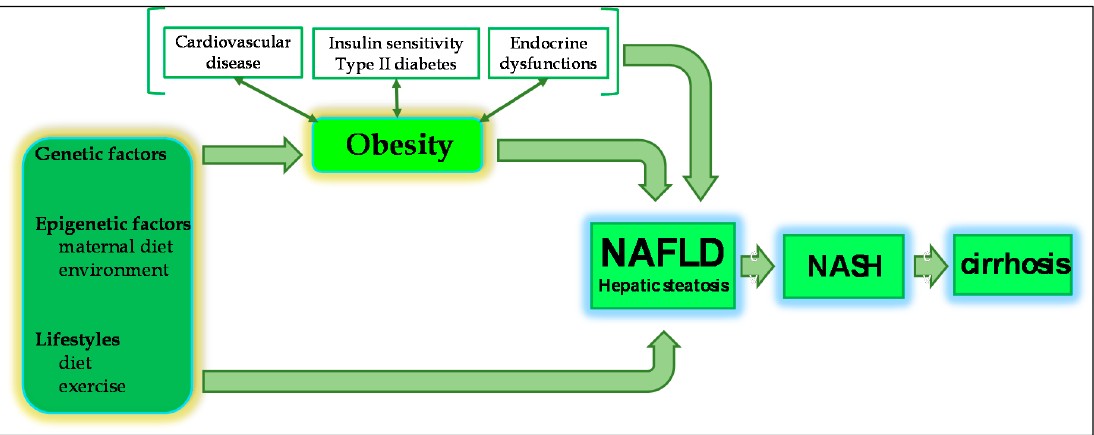
Figure 1. Obesity and Non-Alcoholic Fatty Liver Disease (NAFLD). Abbreviations: NAFLD: non-alcoholic fatty liver disease; NASH: non-alcoholic steatohepatitis.